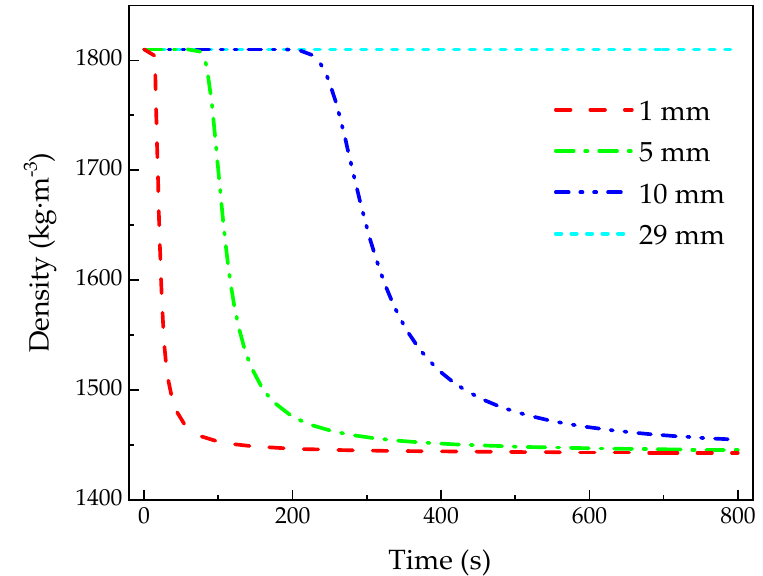
Figure 7. Density curves of the glass fiber/phenolic resin composites under one-sided heating.